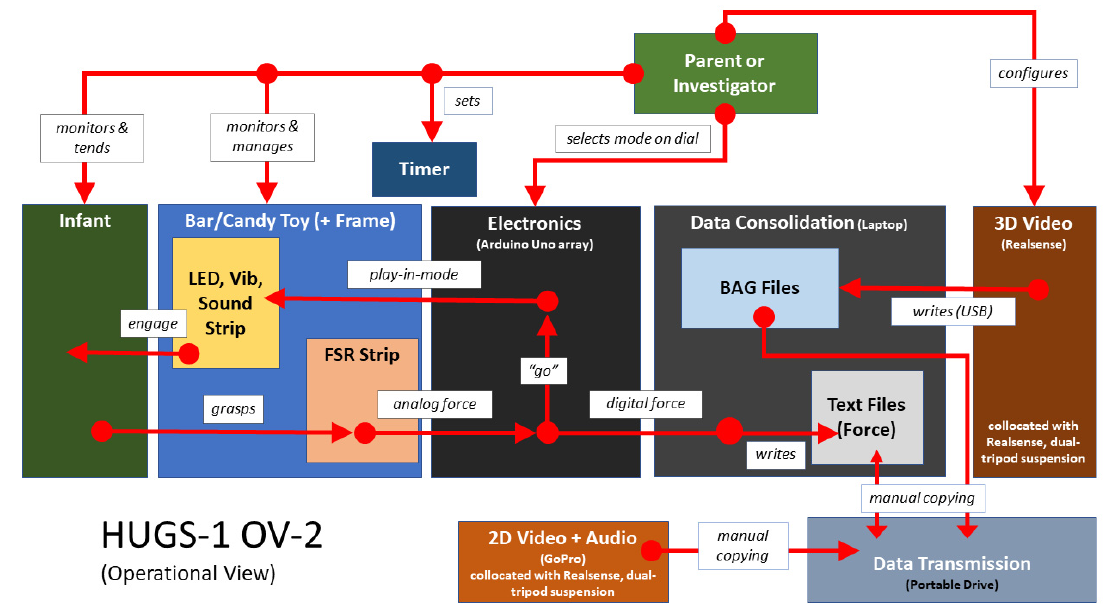
Figure 5. HUGS ‐ 1 system components and interoperation.